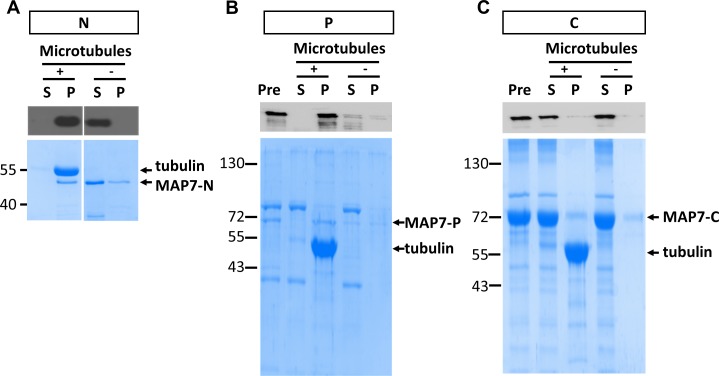
Microtubule binding by individual MAP7 domains in a co-sedimentation assay.Western blot (top) and coomassie staining (bottom) from SDS-PAGE of purified GST-fusion of MAP7-N (N), mCherry fusion proteins of MAP7-P (P) or MAP7-C (C) after sedimentation with or without Taxol-stabilized microtubules. Western blots were probed for the FLAG tag in the GST fusion protein in (A) and the mCherry tag in (B-C). Supernatants (S) and pellets (P) along with pre-binding samples (Pre) were analyzed.